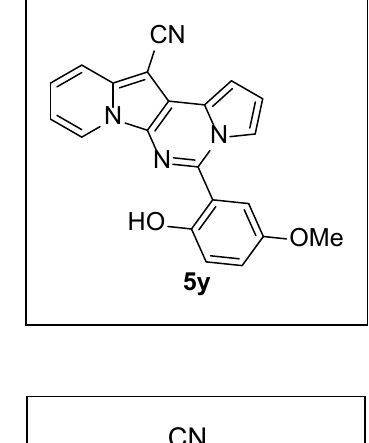
carbonitrile (5y). Yellow solid, m.p.: 240.3–240.7 ◦ C (14.4 mg, 37%); 1 H NMR bonitrile (5y). Yellow solid, mp: 240.3–240.7 °C (14.4 mg, 37%); 1 H NMR (400 MHz, DMSO- d 6 ) δ 9.69 (s, 1H), 8.88 (d, J = 6.6 Hz, 1H), 7.85 (d, J = 8.4 Hz, 1H), 7.47 (d, J = 8.0